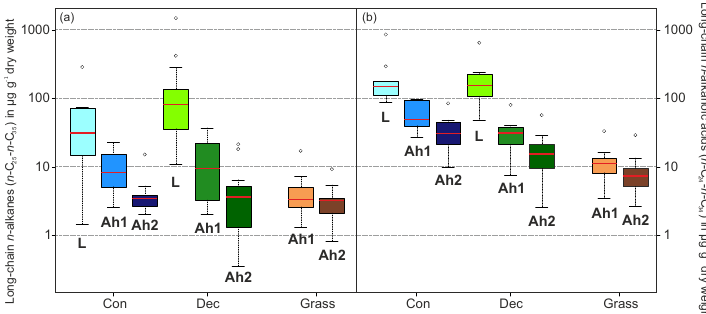
Figure 2. Total concentrations of (a) n -alkanes and (b) n -alkanoic acids in µgg − 1 dry weight. Abbreviations: con, coniferous forest sites ( n = 9); dec, deciduous forest sites ( n = 14); grass, grassland sites ( n = 22); L, litter; Ah1, topsoil 1 (0–3cm); Ah2, topsoil 2 (3–10cm). Box plots show median (red line), interquartile range (IQR) with upper (75%) and lower (25%) quartiles, lowest datum still within 1.5 × IQR of lower quartile, and highest datum still within 1.5 × IQR of upper quartile. Note that the y axis is